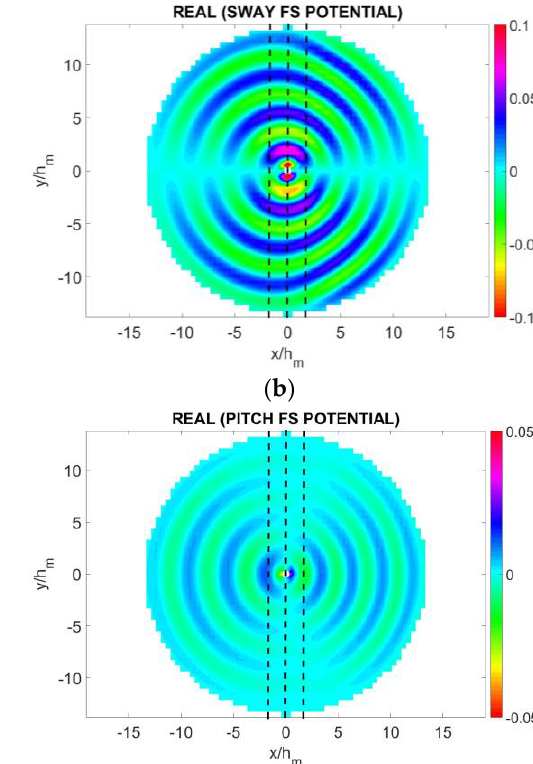
Figure 7. Radiation fields on the free surface for WEC frequency ω 0.7 a g over the variable bottom topography ( h 1 =1.5 m, h 3 =0.5 m, α bot = 0.5), as calculated by the present method. ( a ) surge, ( b ) sway, ( c ) roll, ( d ) pitch.